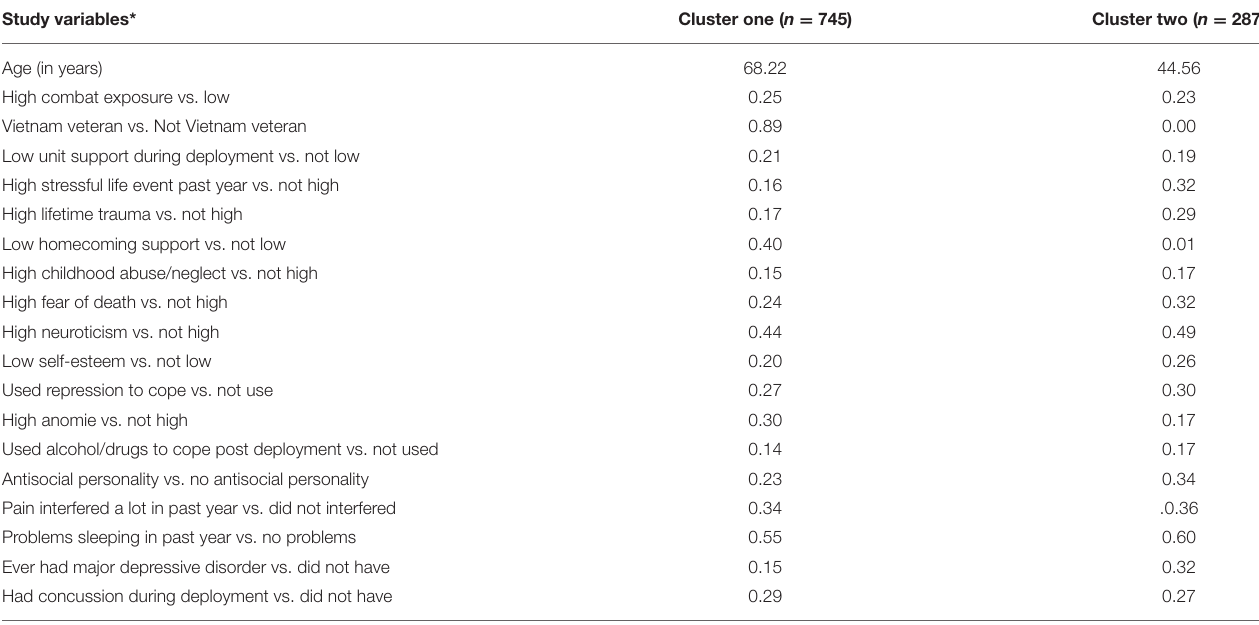
TABLE 4 | Moral injury cluster analysis results using study predictor